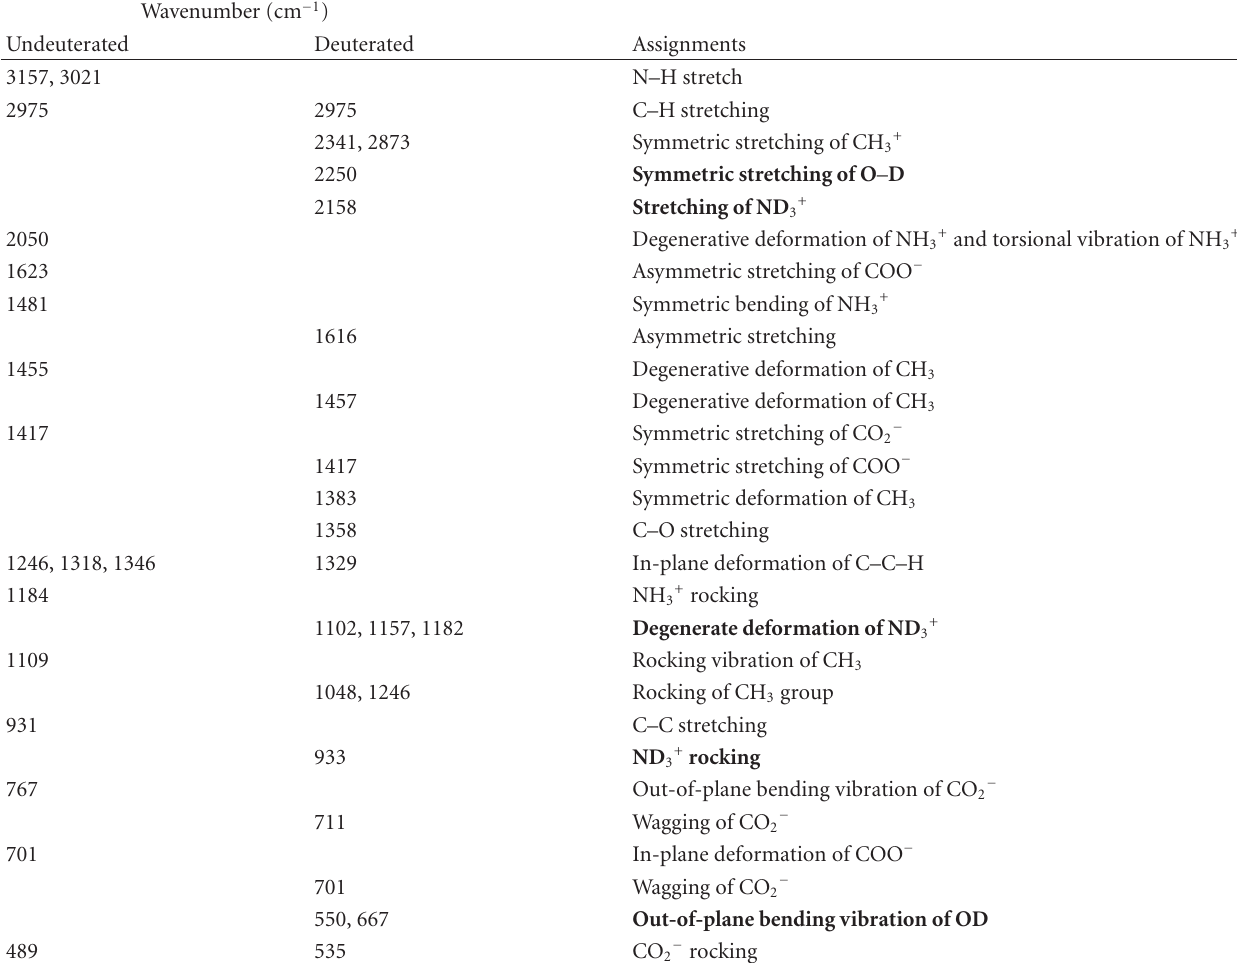
Table 7: Deuterated and undeuterated L-threonine assignments on IR